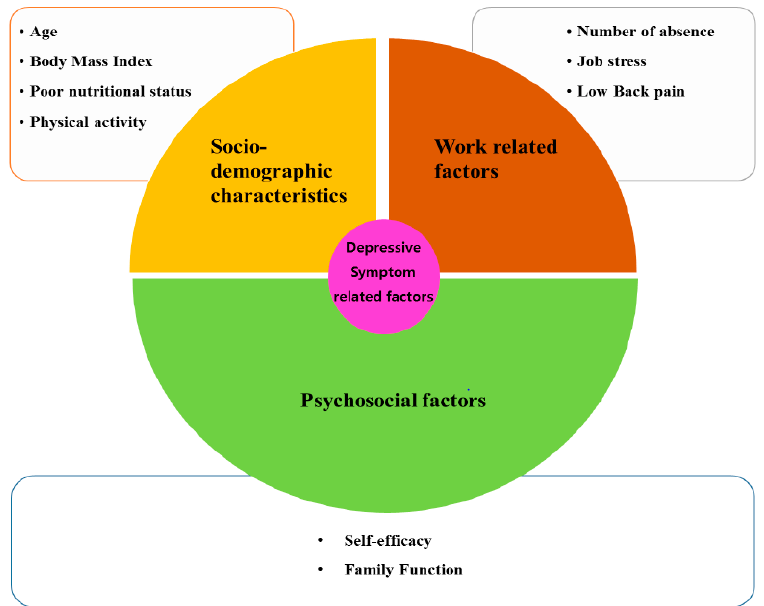
Figure 1. Conceptual framework of the study.